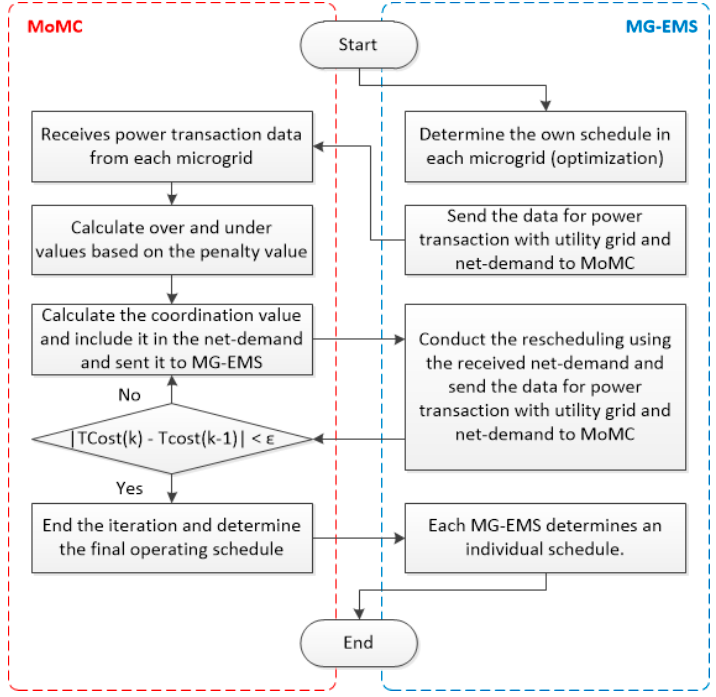
Figure 3. The flowchart of the proposed algorithm.